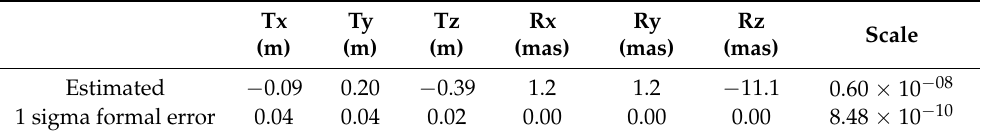
Table 1. Helmert parameters relating the origin, orientation and scale of the Broadcast reference frame of G01 relative to the IGS14 frame of the SP3 precise ephemeris, 2 January 2020. ‘mas’ stands for